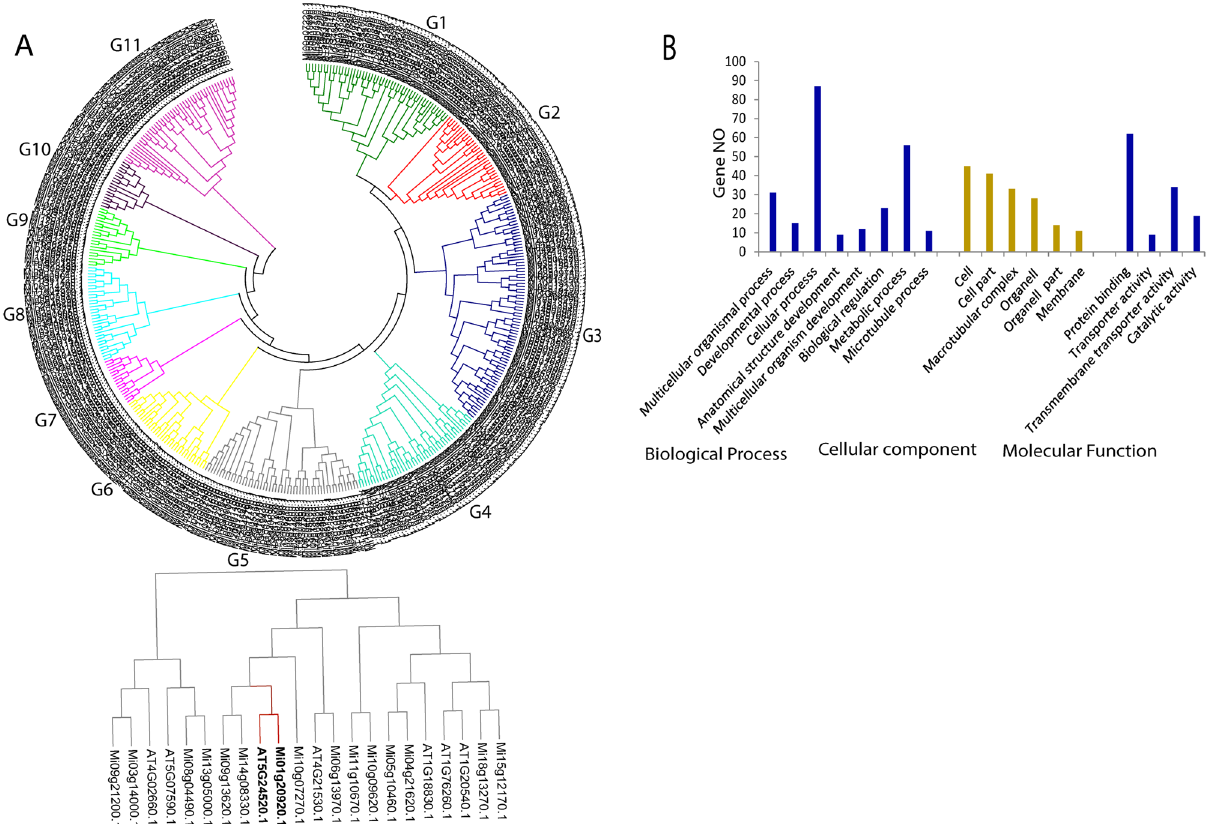
Figure 1. Functional analysis of mango WD40 proteins family. ( A ) Phylogenetic tree relationship between mango and Arabidopsis of WD40 proteins was conducted by MEGA 6.0 using the Neighbor-Joining (NJ) method. The11 subgroups are shown in colors. ( B ) GO annotation analyses of mango WD40 proteins were examined for their functions in biological process, molecular functions and cellular